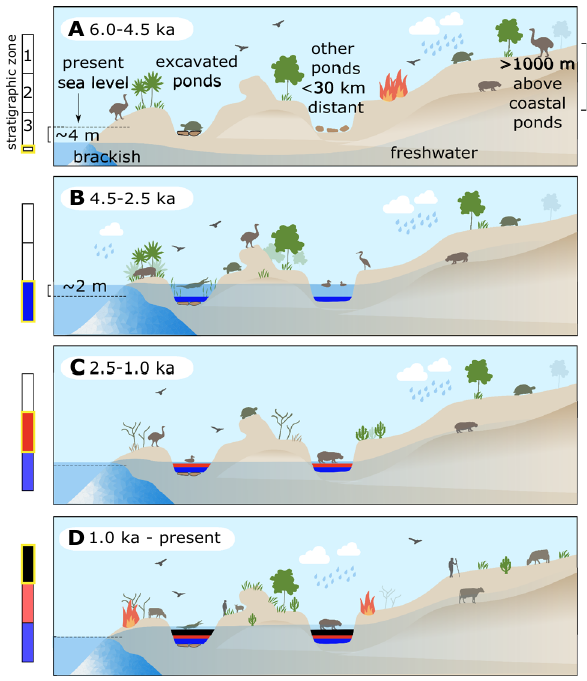
Figure 6. Schematic environmental reconstruction of the study region illustrating changes in relative sea level and climate that contributed sedimentation during relatively wet and dry intervals. Cartoons illustrate changes in vegetation and animal occurrence data from the excavated ponds, other ponds that are < 30 km distant, and sites excavated in the uplands. For example, crocodiles have been 14 C-dated from the lowland coastal sites during the relatively wet interval ~ 4.5–2.5 ka and were known locally prior to extirpation during the past